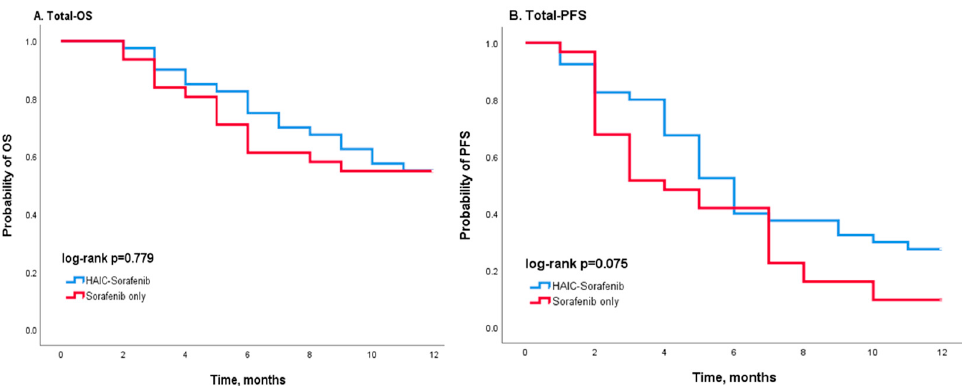
Figure 2. Kaplan–Meier survival analysis according to different treatments (HAIC-sorafenib versus sorafenib alone) for patients with HCC: ( A ) OS and ( B ) PFS. Blue, sorafenib with HAIC; red, sorafenib alone. HAIC, hepatic arterial infusion chemotherapy. Although the survival curves show a better OS and PFS in the combination group than in the sorafenib group, the log-rank test indicates no significant statistical difference between the survival curves.